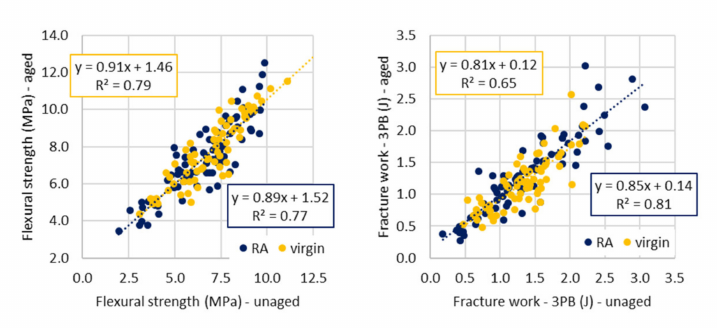
Figure 4. Comparison of aged and referential parameters for different groups of mixes—three-point bending